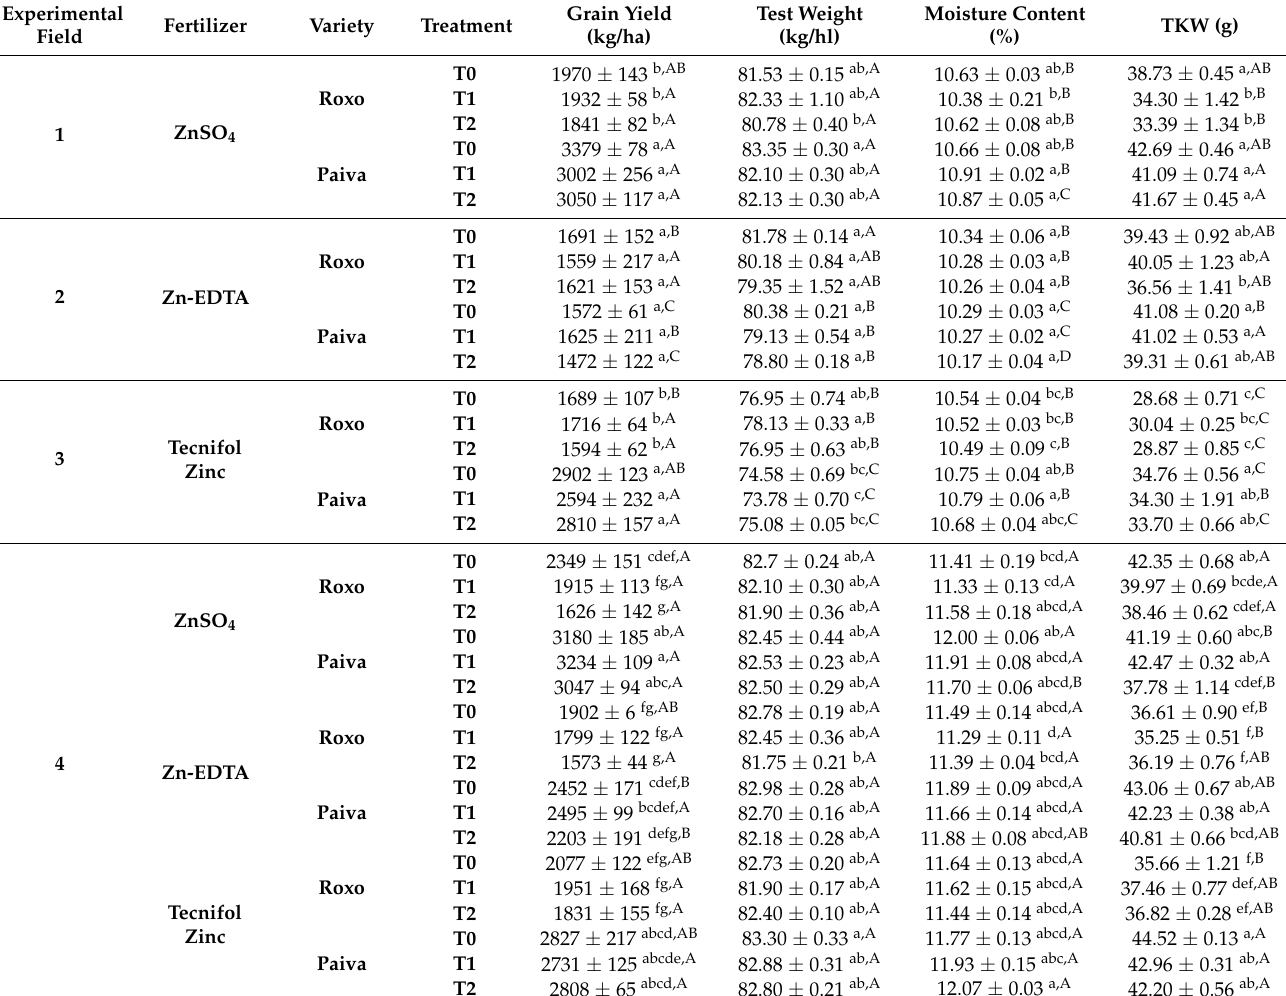
Table 3. Grain Yield, Test Weight, Moisture Content and Thousand Kernel Weight (TKW) ( n = 4) of Triticum aestivum L. grains, varieties Roxo and Paiva, from 1–4 experimental fields. Experimental